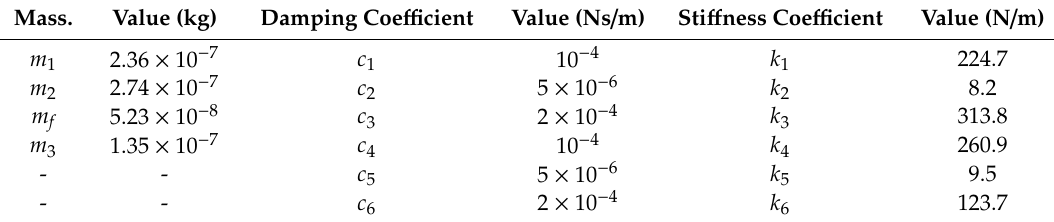
Figure 2. Lumped parameter model of the four-degree-of-freedom (4-DOF) micro gyroscope. Table 1. The values of the physical parameters of the